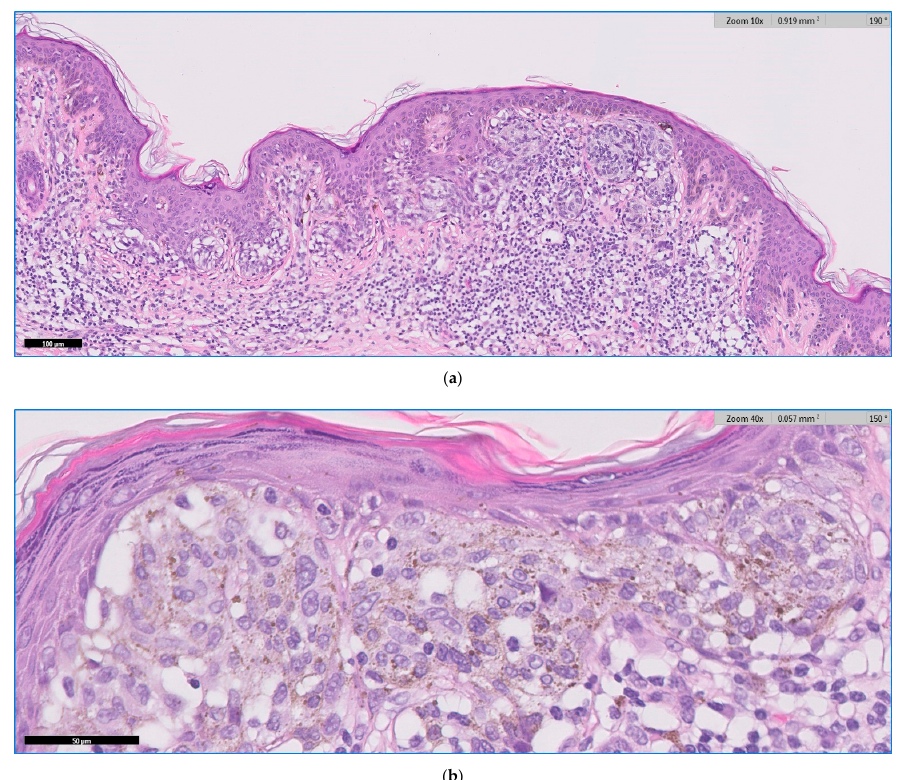
Figure 6. ( a , b ) HE. Fusion of junctional melanocytic nests with low ‐ grade dysplasia.